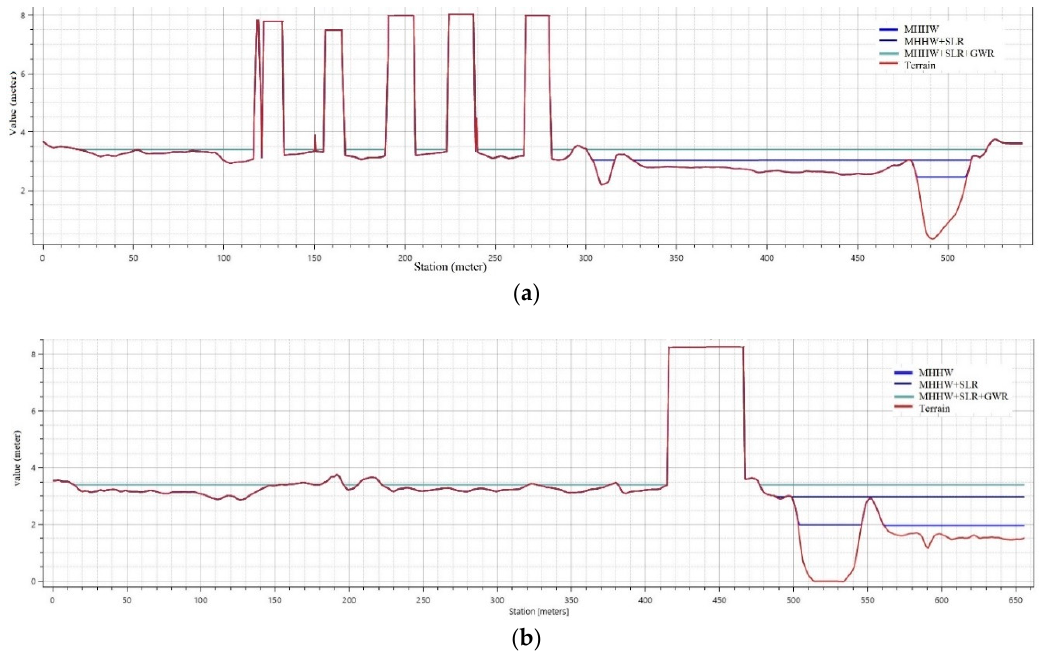
Figure 9. Water elevation in different scenarios at ( a ) Cross Section 1, and ( b ) Cross Section 2.